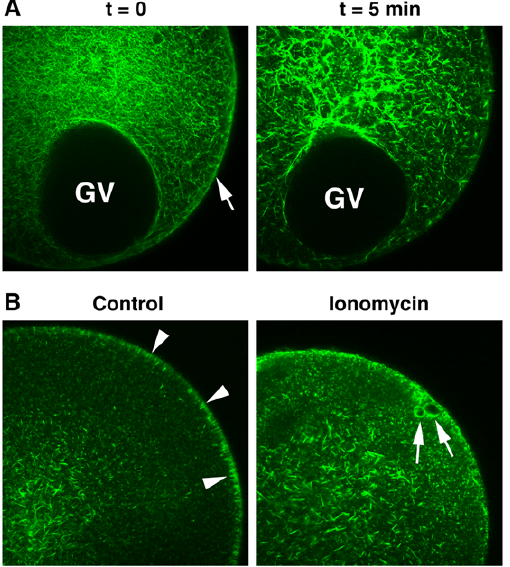
Figure 3. Ionomycin induces rapid rearrangement of the actin cytoskeleton. ( A ) A living oocyte ( A. aranciacus ) microinjected with Alexa Fluor 488-conjugated phalloidin was exposed to 5 m M ionomycin and monitored under the confocal microscope. Note the continuous layer of the subplasmalemmal actin network delineating the plasma membrane before the ionomycin treatment (arrow, t=0) had mostly disappeared within 5 min in the same oocytes. In contrast, the actin filaments in the inner cytoplasm formed bundles and became much thicker and longer. ( B ) After the brief exposure (5 min) to 5 m M ionomycin, the oocytes were switched to normal seawater without ionomycin and induced to undergo meiotic maturation in the presence of 10 m M 1-MA for 1 hour. The orderly arranged actin filaments seen in the control eggs (arrowheads) are mostly lost in the eggs briefly exposed to ionomycin at the GV stage. Instead, a thick layer of actin fibers surrounded the big fused white vesicles (arrows).